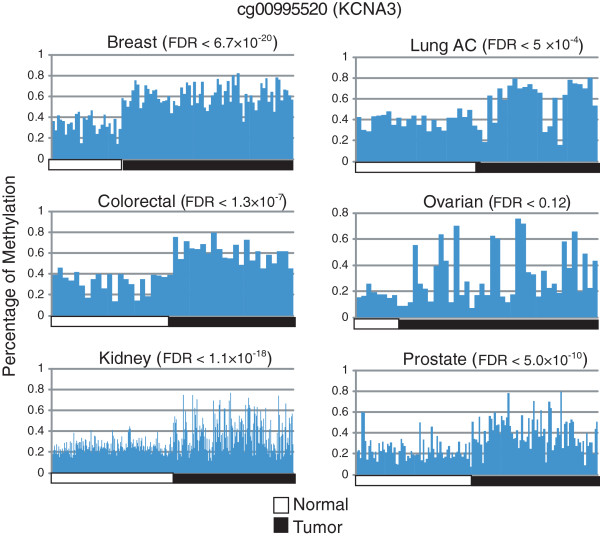
Hypermethylation in the KCNA3 promoter region across multiple cancer types. Voltage gated channel activity is highly enriched with hypermethylated genes. The silencing of potassium voltage-gated channel, shaker-related subfamily, member 3 (KCNA3) via promoter methylation has been reported in breast and pancreas tumors. Here, we observe KCNA3 promoter methylation as a prevalent event across multiple cancer types including lung, ovarian, kidney, prostate, and colon. FDR levels were calculated using LIMMA package as described in methods.